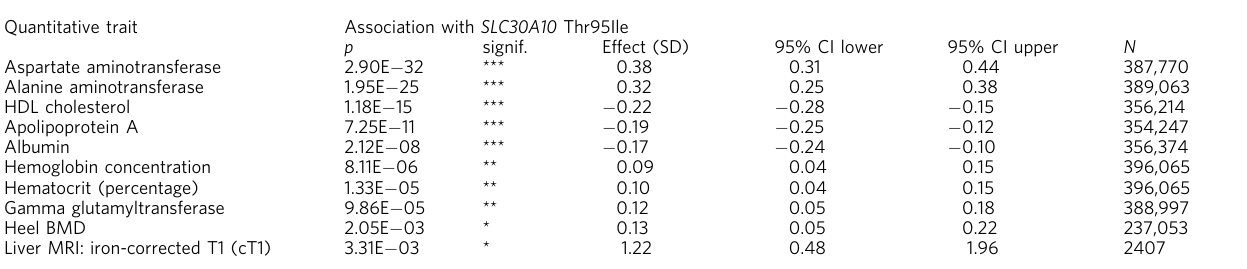
Table 1 Association results of SLC30A10 Thr95Ile with selected quantitative traits. Quantitative trait Association with SLC30A10 Thr95Ile p